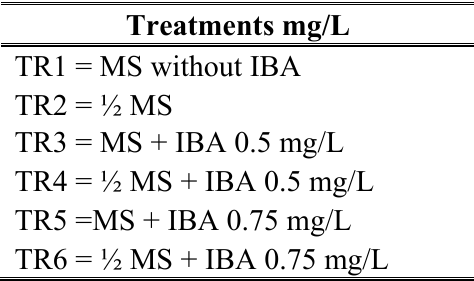
Table 3. Rooting treatments (IBA +